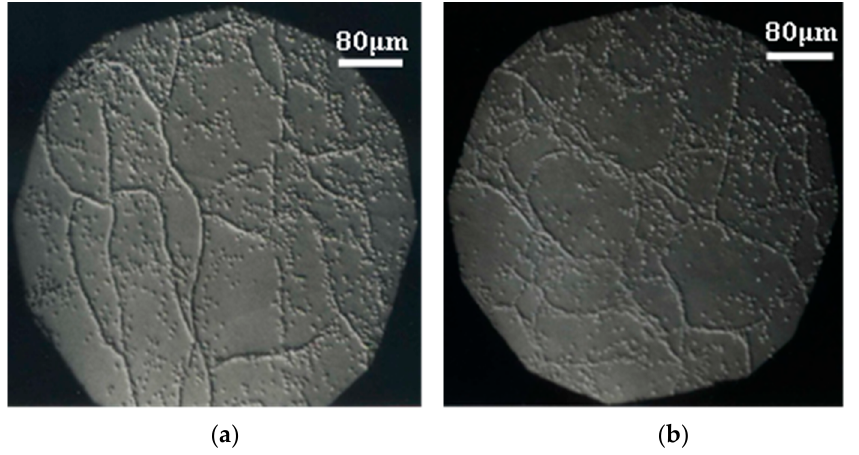
Figure 1. ( a ) CdTe, v = 3.32 mm/h, δ = 1.2 × 10 6 cm − 2 , ϕ = 23 ″ ; ( b ) CdTe, v = 1.66 mm/h, δ = 1.3 × 10 6 cm − 2 , φ = 24 ″ .